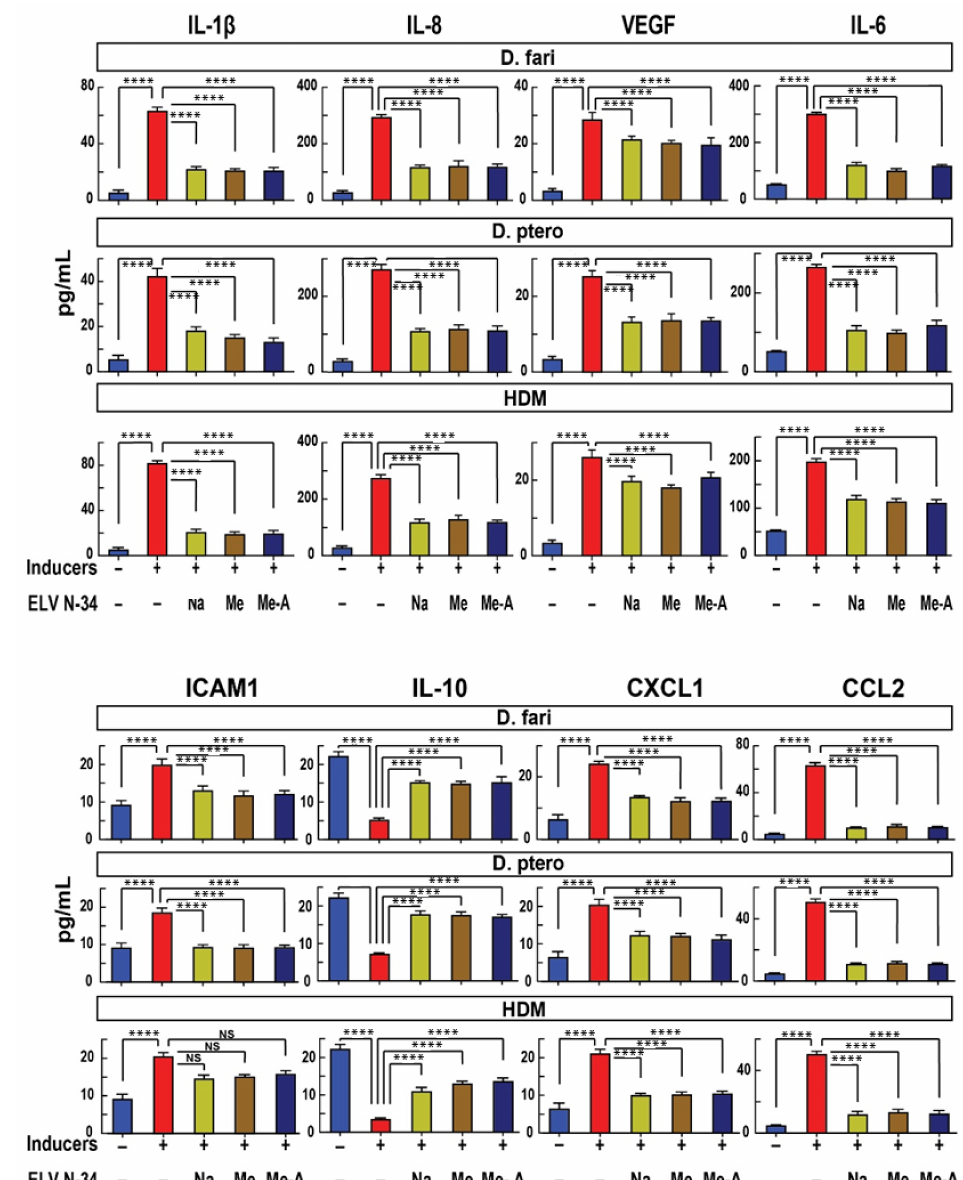
Figure 4. ELVN-34 reduce the expression of pro-inflammatory cytokines, chemokines, and cell adhesion molecule in HNEpC challenged with D. farinae , D. pteronyssinus , and HDM ( D. fari + D. ptero ) (30 µ g/mL). ELVN-34 reduce the expression of pro-inflammatory cytokines, chemokines, and cell adhesion molecule ICAM1 in HNEpC exposed to HDM inducers. A remarkable decrease was observed in the release of anti-inflammatory cytokine IL-10 in HNEpC challenged with the HDM stressors ( D. farinae , D. pteronyssinus , and HDM) (30 µ g/mL). This decreased production of anti-inflammatory cytokine is reversed by the addition of ELVN-34 (500 nM), 30 min post-challenge with the stressor. The results showed the averages of three independent experiments. (**** p < 0.0001, NS—not